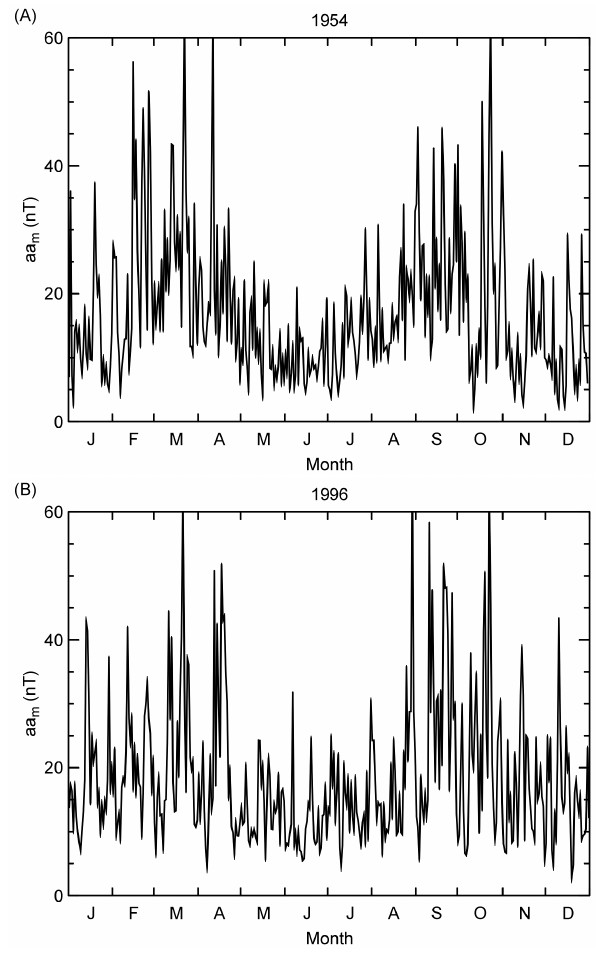
Fig. 1. Plots of daily values of the aa m index for (a) 1954 and (b) 1996.